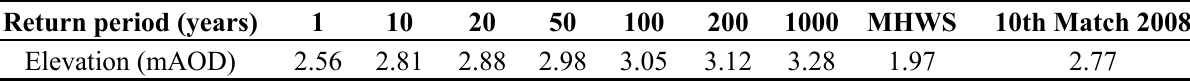
Table 1. Return still water levels at Portsmouth in 2008 [57], mean high water springs, and the still water level recorded during a recent storm surge. The water level datum referred to (mAOD) is approximately mean sea